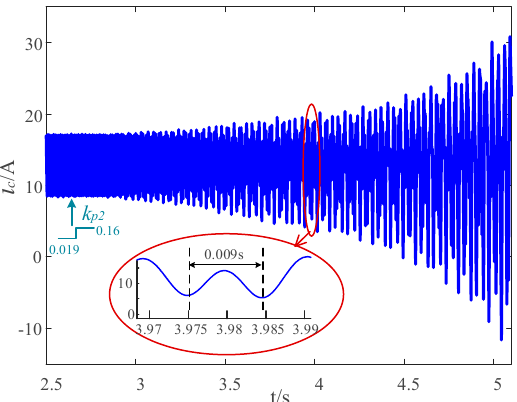
= 0.162 while other parameters remain